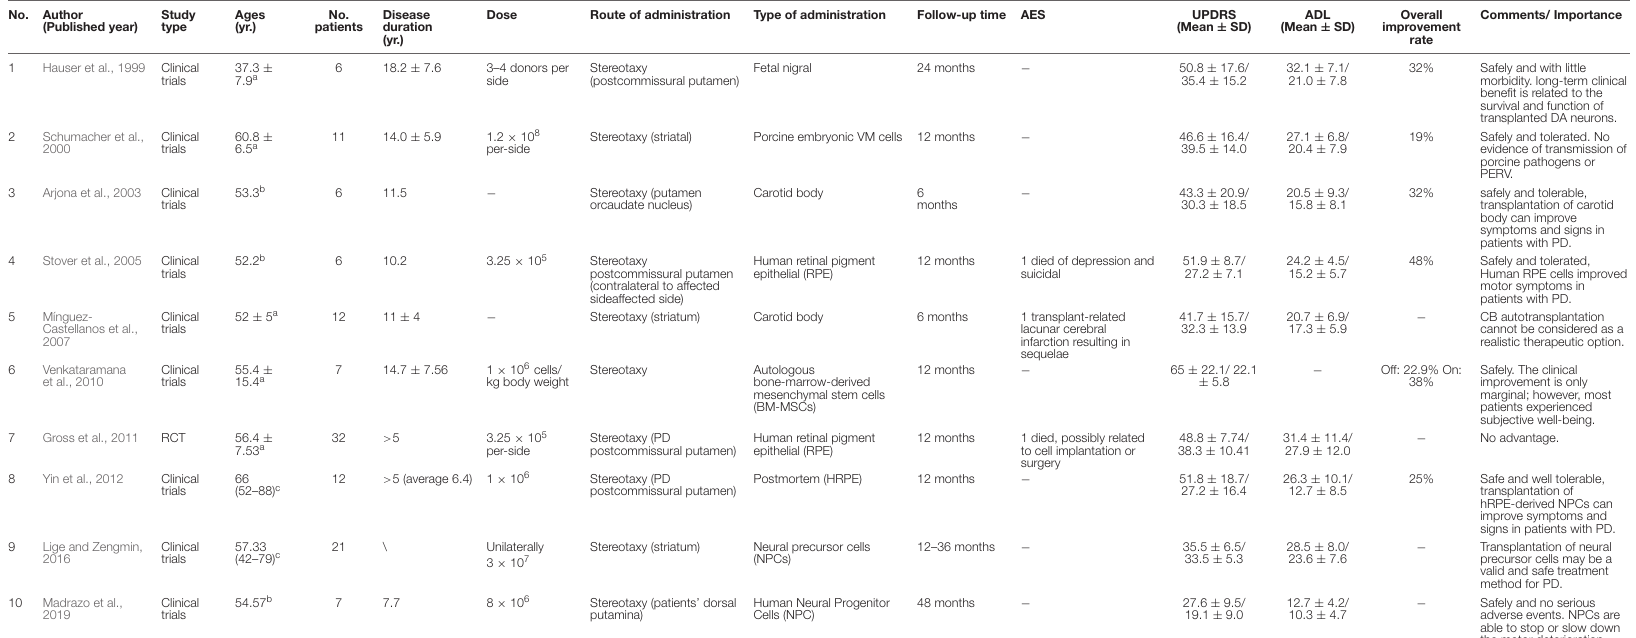
TABLE 1 | Characteristics of the articles included in the final literature